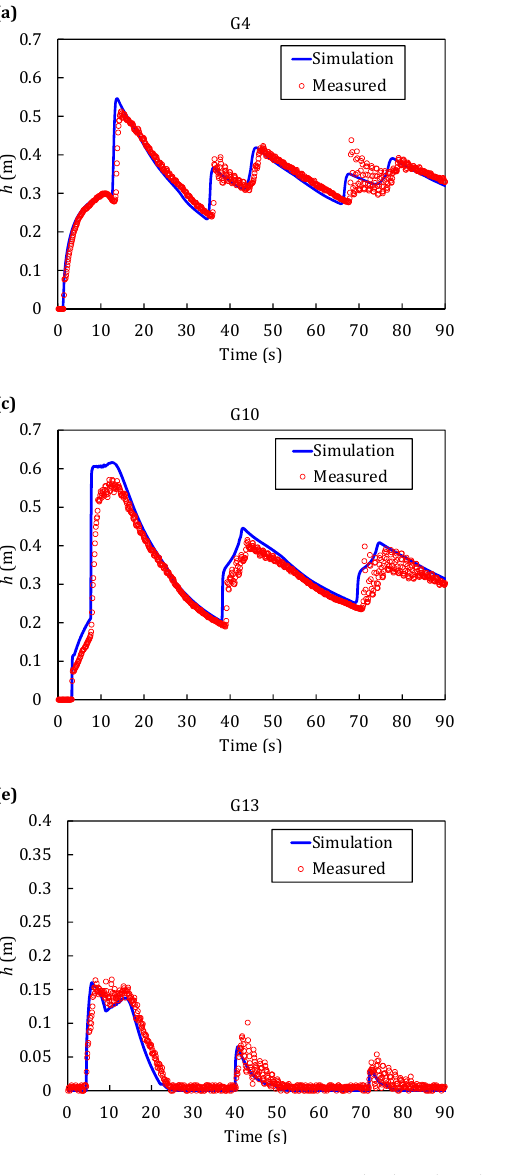
Figure 8. Calculated and measured water depth at six